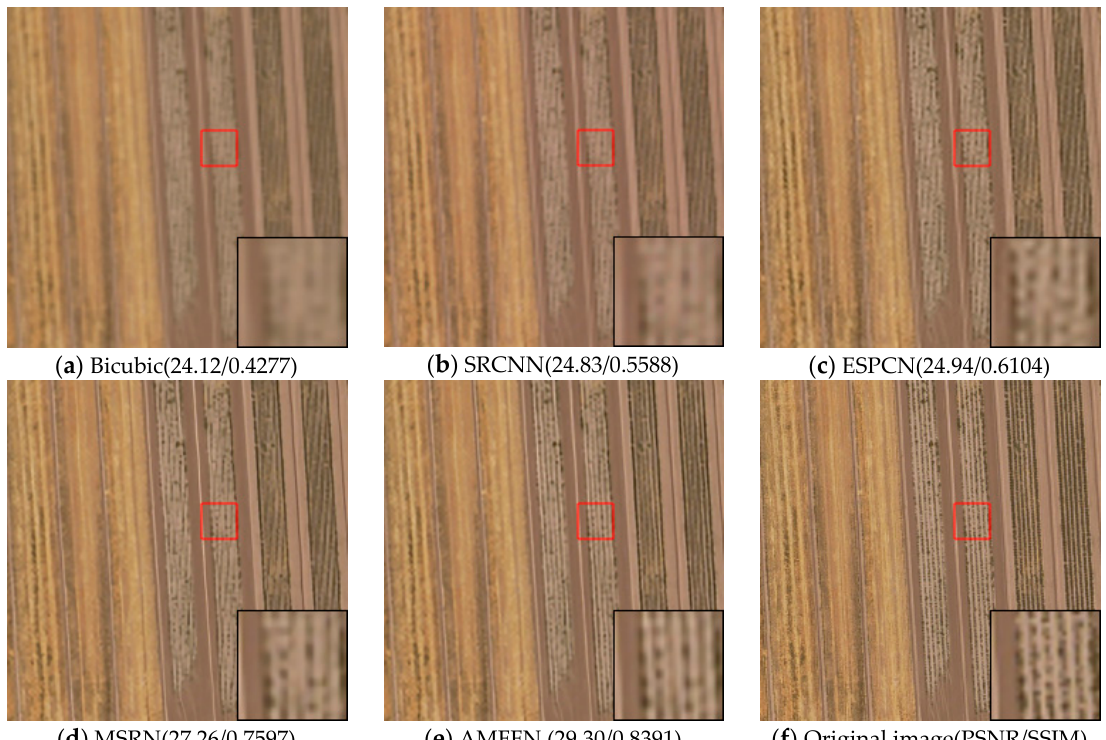
Figure 8. Results of farmland scenes in UC dataset of different methods with scale factor ×2.